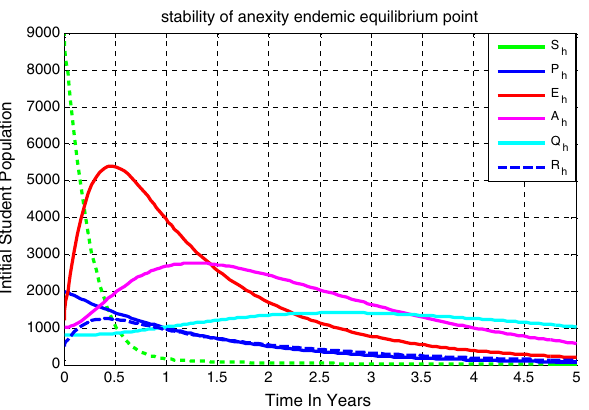
Figure 2. Model solutions trajectory over time ( R eff > 1 )